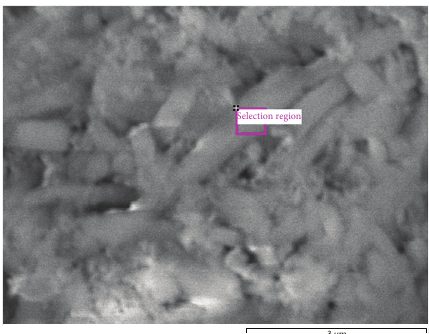
Figure8:TheSEMpictureofbuildingpiecesindisintegratedARFA. The region in the square has been selected for EDX elemental analysis (Al/Si molar ratio of